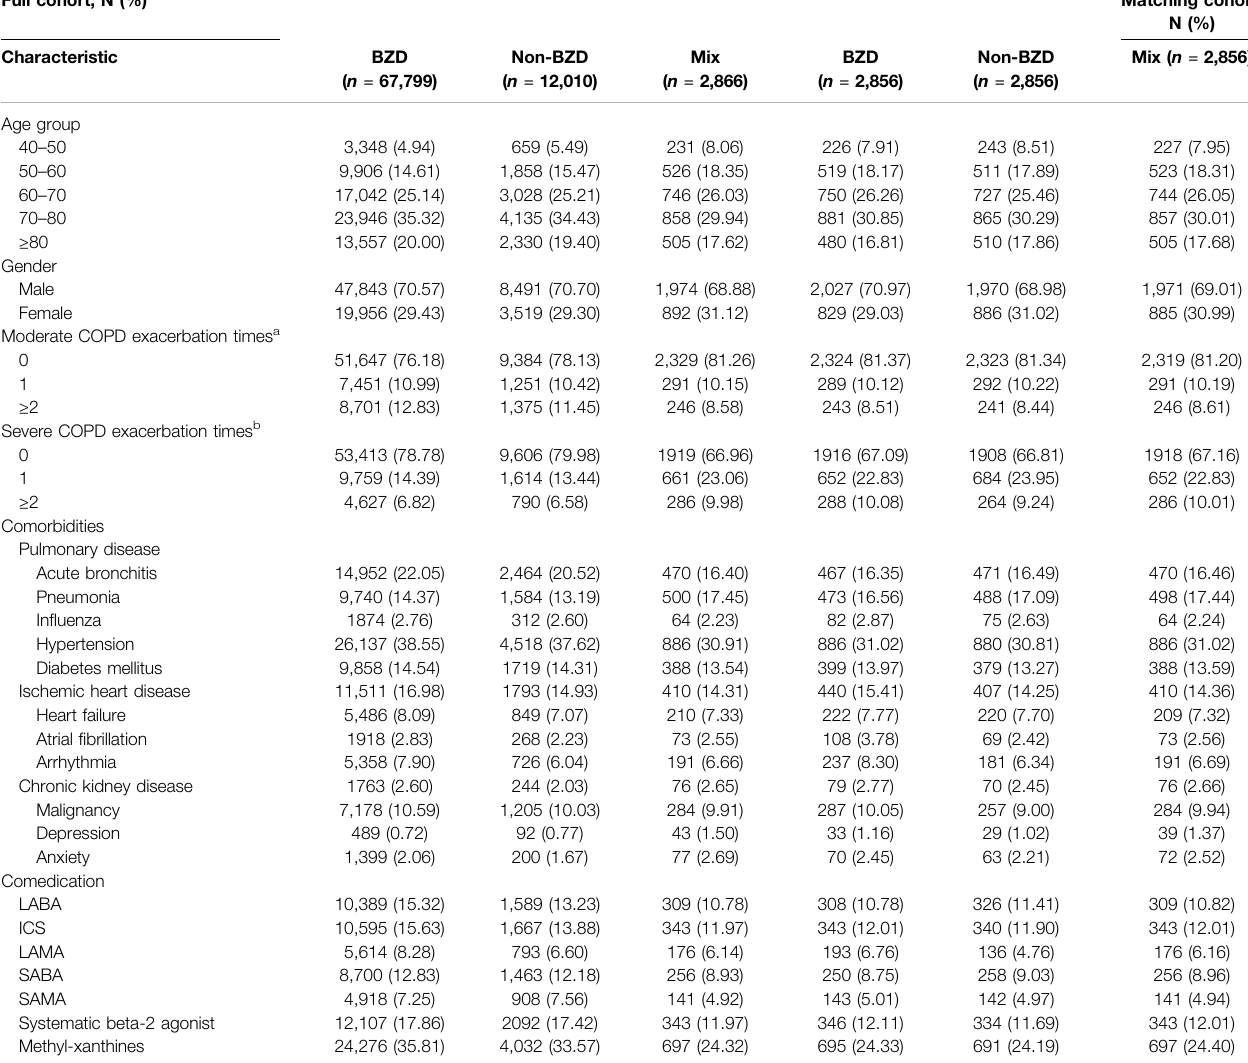
TABLE 1 | Baseline characteristics of the full cohort and matching